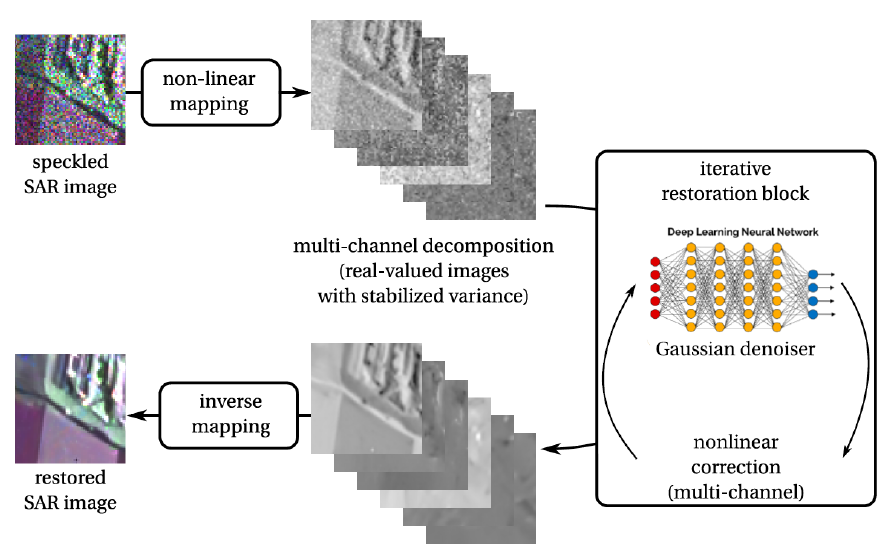
Figure 15. DNN-based PolSAR despeckling method